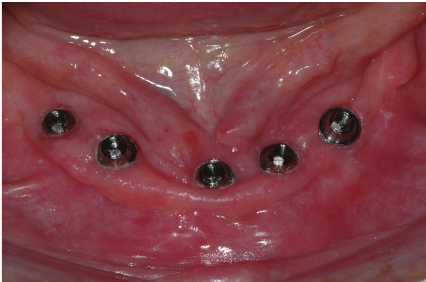
Figure 15: Clinical aspect of the peri-implant tissue after 2 years of